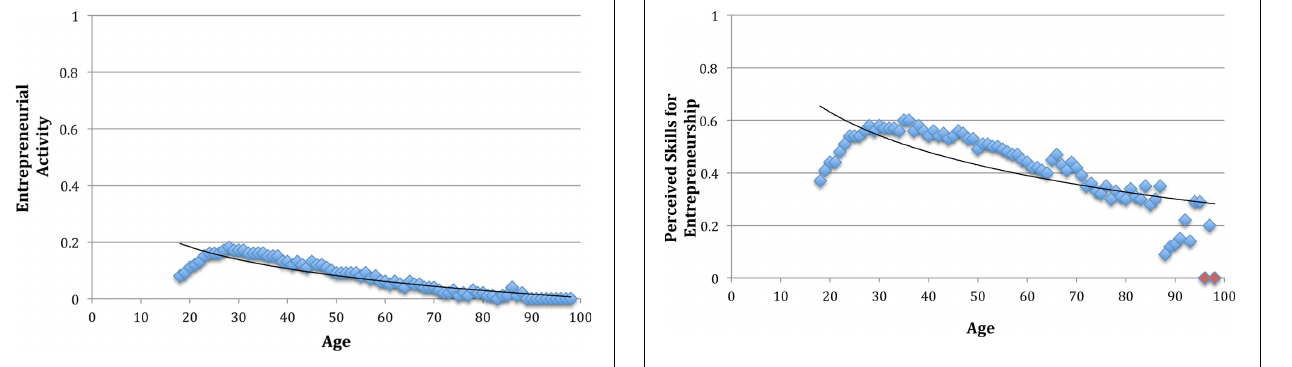
FIGURE 4 | Plot of perceived skills for entrepreneurship across the lifespan (16–97 years). Red dots indicate extreme age groups, consiting of very few observations (i.e., N = 2 for age 96, N = 1 for age 98). The trendline depicts the logarithmic relationship between age and perceived opportunities for